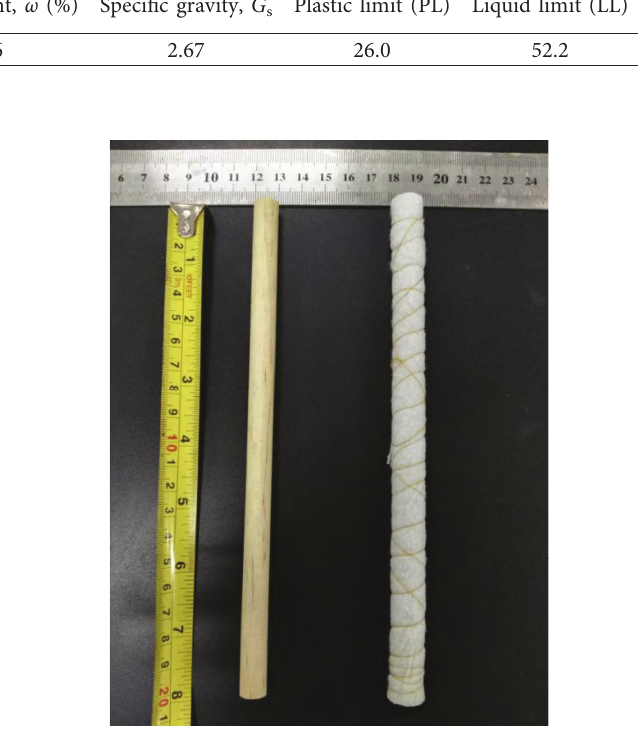
Figure 2: Photos of timber rod and drained-timber rod for a wooden rod with a diameter of 10mm.